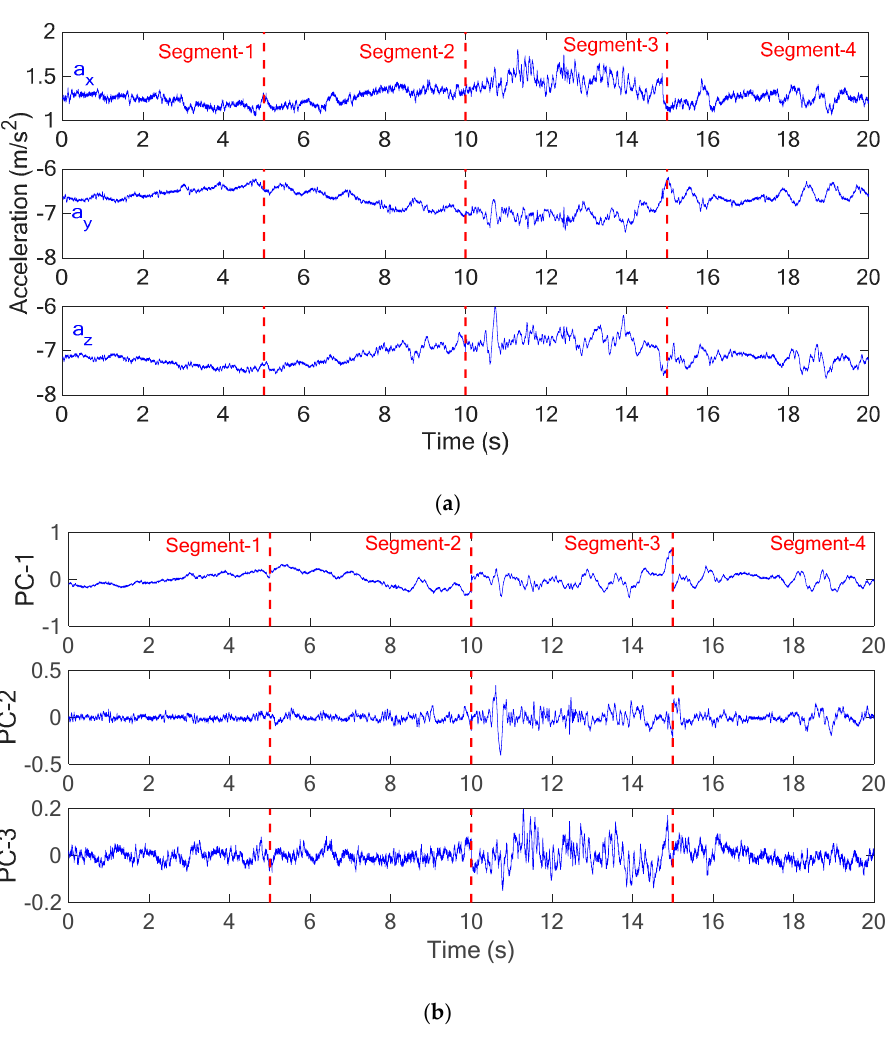
Figure 8. ( a ) Segments of acceleration measurements, ( b ) Principal components in each segmentalized part.